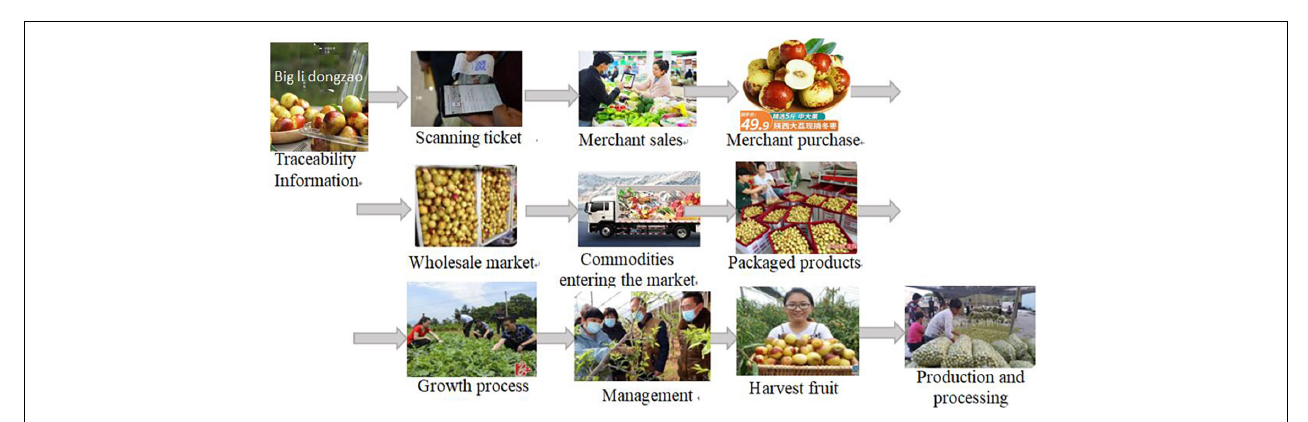
FIGURE 5 | Data processing of XRJ traceability system.